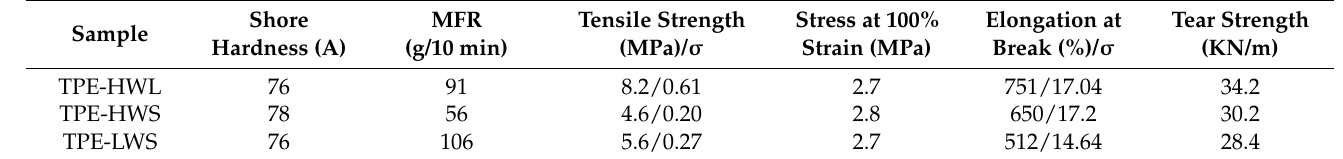
Table 7. Mechanical properties of TPE prepared by SEBS with various molecular chain structures.